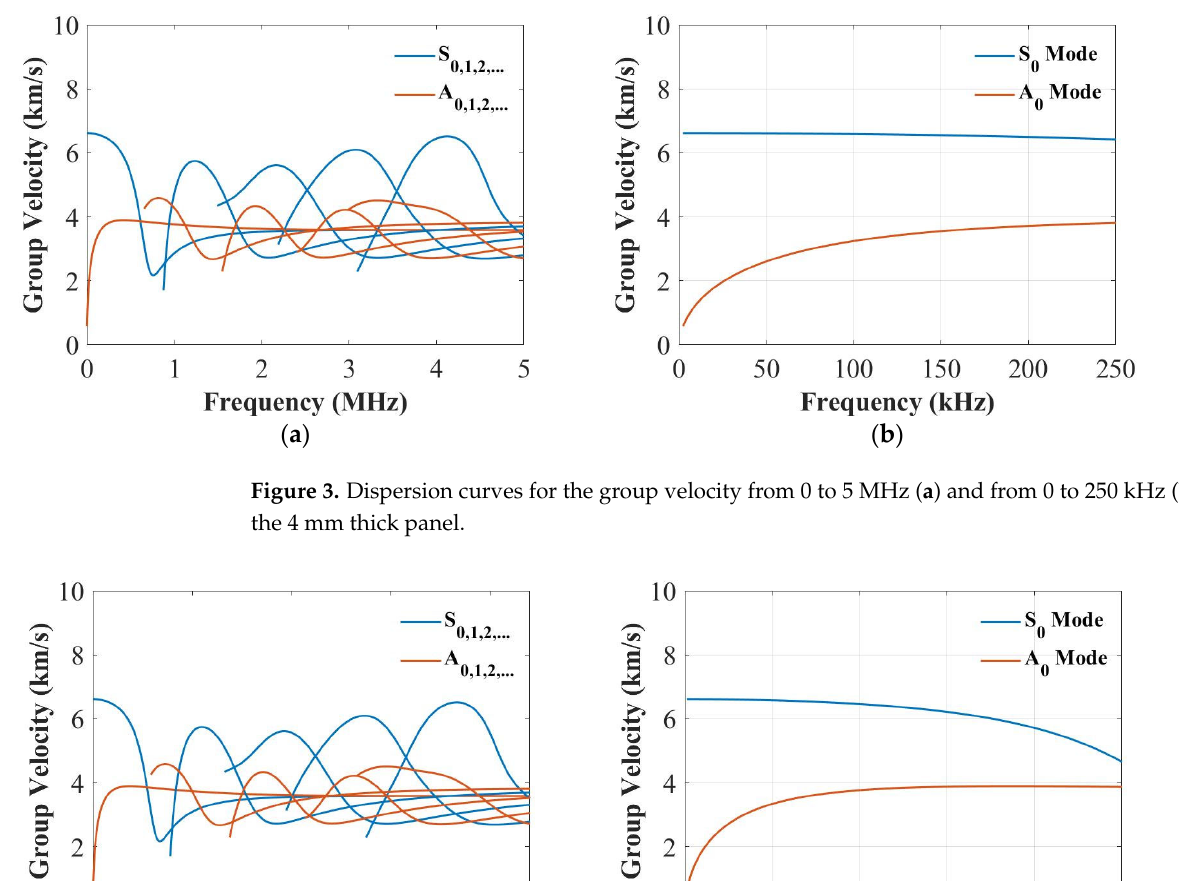
Figure 2. Dispersion curves for the group velocity from 0 to 10 MHz ( a ) and from 0 to 250 kHz ( b ) for the 2 mm thick panel.